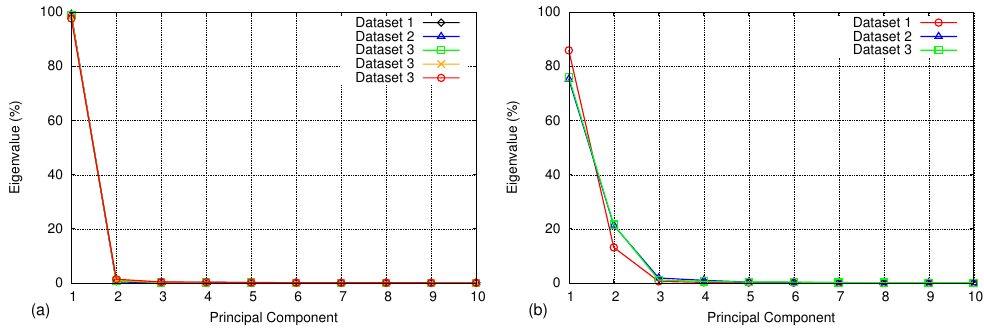
Figure 5. ( a ) Comparison of the first ten principal components using five sets of input data taken during regular breathing and ( b ) three sets of input data taken during irregular breathing. The first principal component is dominant over others and represents over 98% of data variance for regular breathing, while three principal components are needed to cover 98% of data variance for irregular